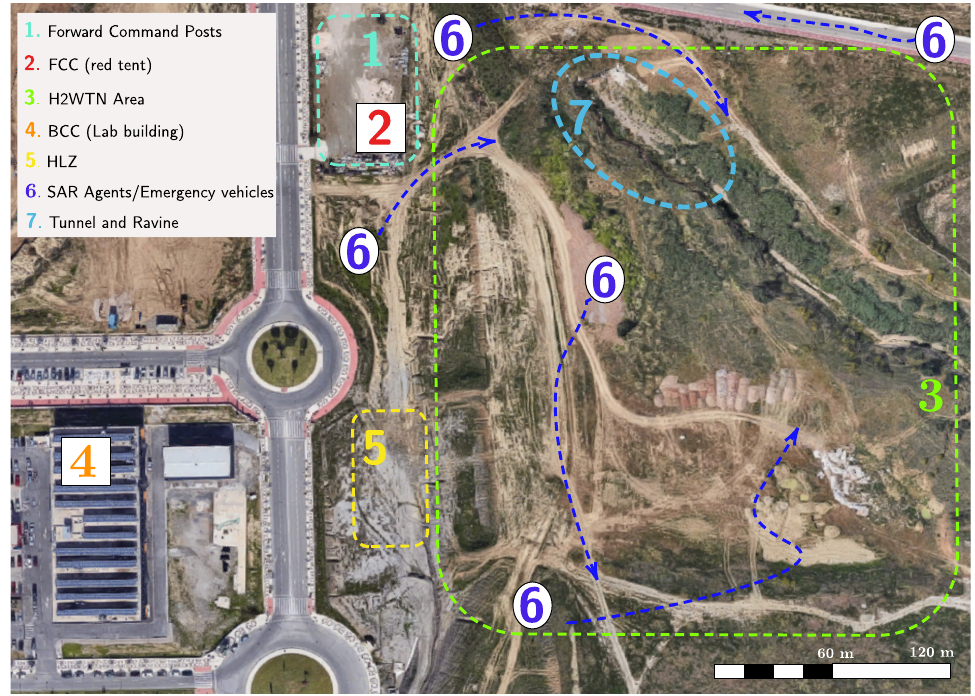
Figure 7. Aerial view (Google 2020) of the area of experimentation in new technologies for emergen- cies (LAENTIEC) where areas indicate some relevant locations, such as MEC centers (2 and 4) or crushed vehicles